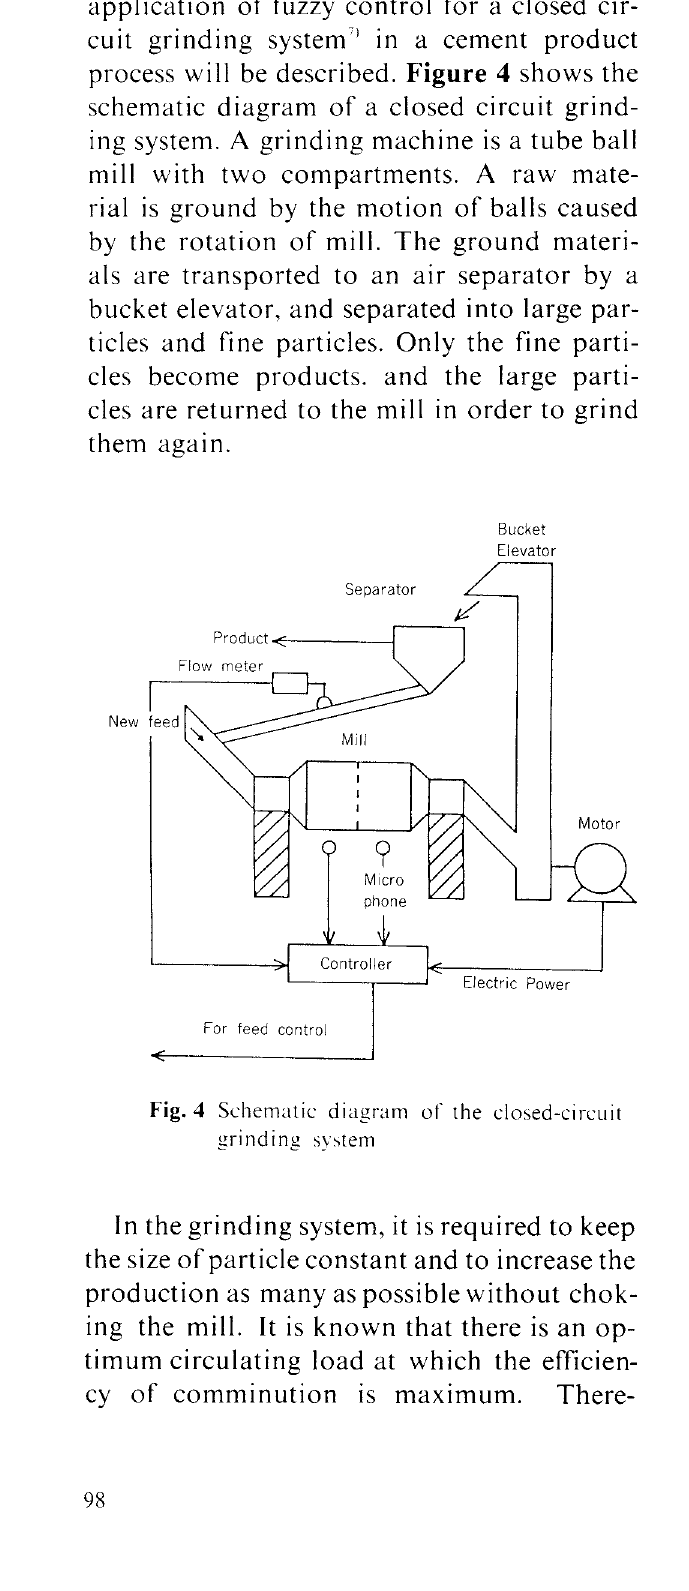
Fig. 5 Relation bet\\een the ratio of production for the ne\\ feed quantity and the circulating